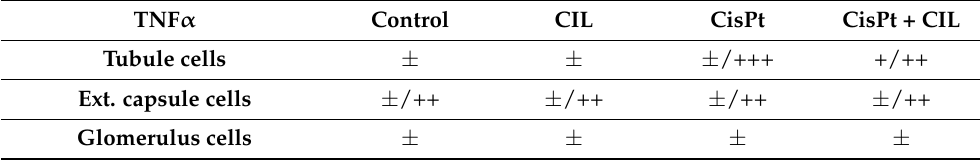
Table 2. Intensity of specific fluorescence signal for TNF α , FKBP51, AmotL2 and IQGAP1 in kidney cell types from control, cilastatin-treated (CIL), cisplatin-treated (CisPt), cilastatin-protected cisplatin-treated (CisPt + CIL) groups of rats. Intensity levels: ± basal-faint, + low, ++ medium, and +++ high. TNF